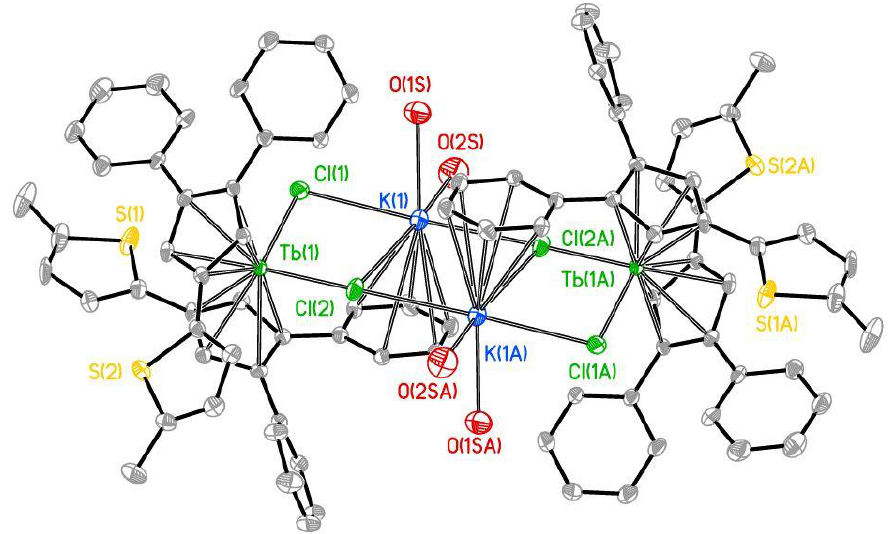
Figure 1. The general view of 3a in representation of atoms by thermal ellipsoids ( p = 50%). The carbon atoms of THF are omitted for clarity.